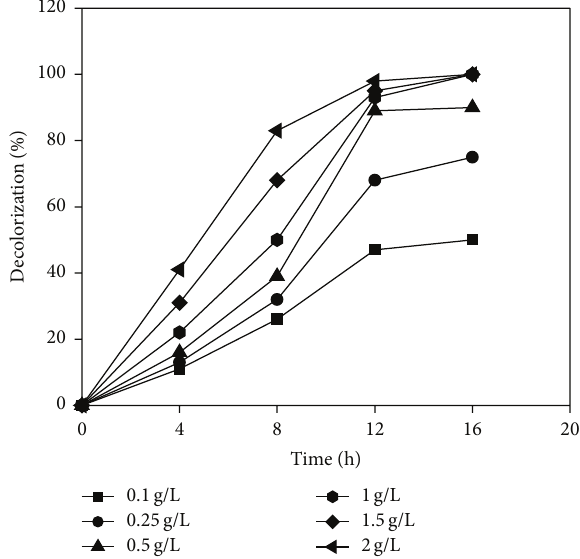
Figure 8: Effect of yeast extract concentration on decolorization of Reactive Violet